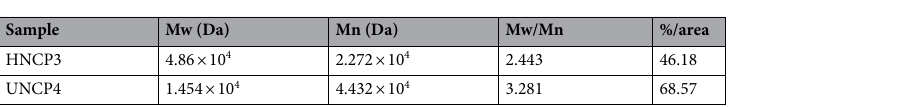
Table 1. Molecular weight distributions of HNCP3 and UNCP4 extracted by different methods. Mw Weight- average molecular weight; Mn Number-average molecular weight; Mw/Mn Polydispersity index.